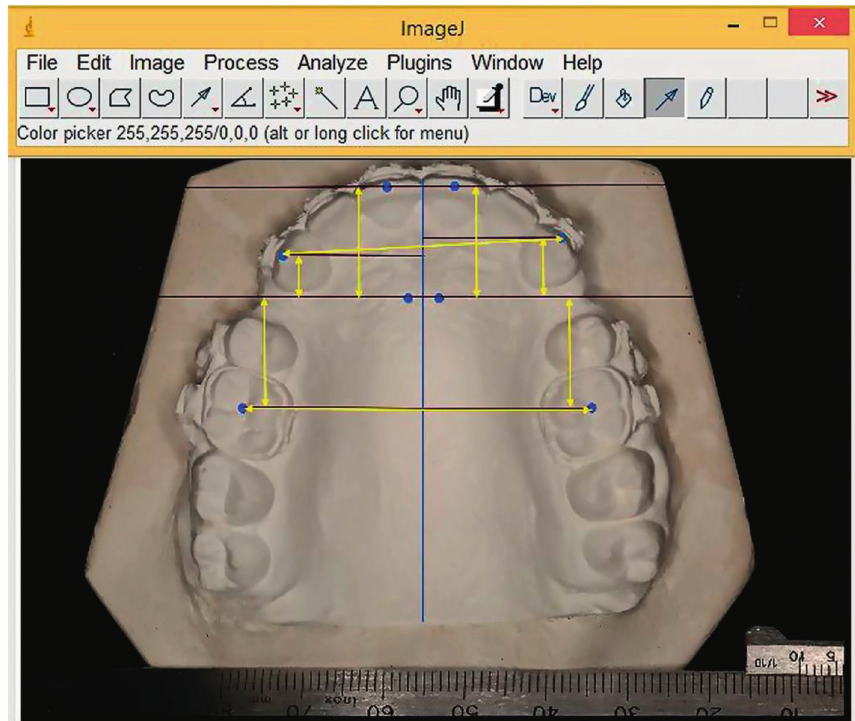
Figure 5: Measurements on digital photographs using the ImageJ